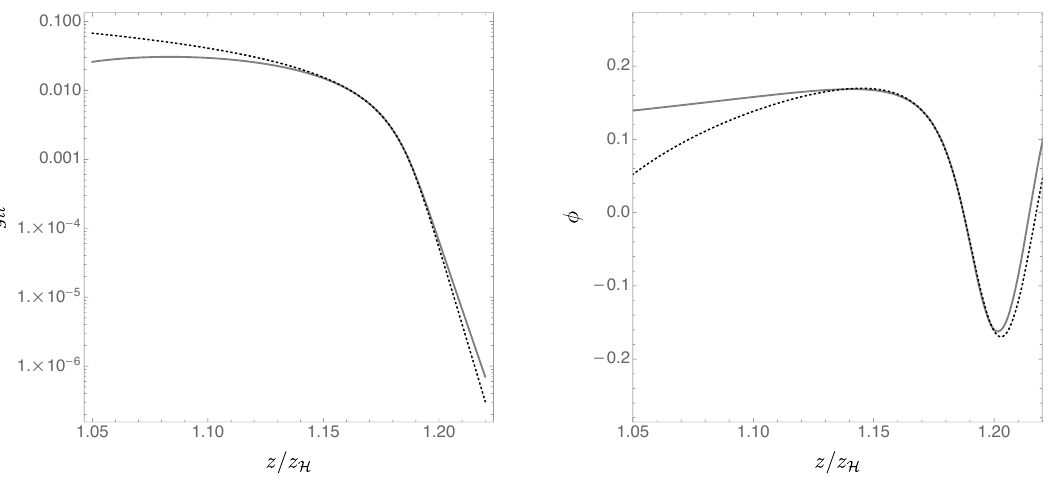
Figure 3: Metric component g and scalar φ as a function of z close to the collapse of tt the ER bridge. The solid gray line is numerical data and the black dotted curves are = 0.9936 and with m 2 = − 2 fits to the expressions (16) and (17). These are at T / T c and q =